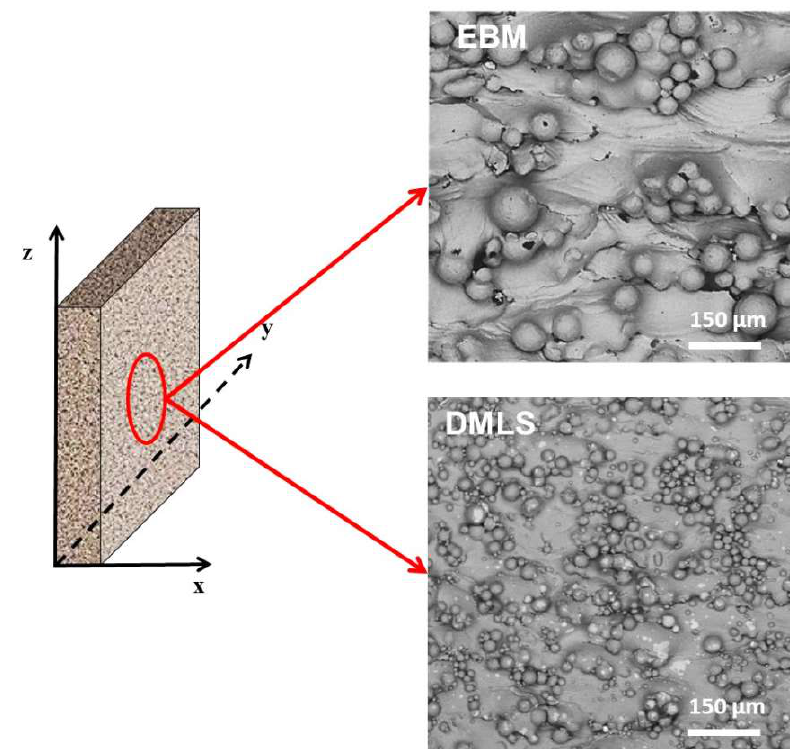
Figure 5. The surface appearance of the as-produced EBM (on top) and the as-produced DMLS (on bottom) specimens.